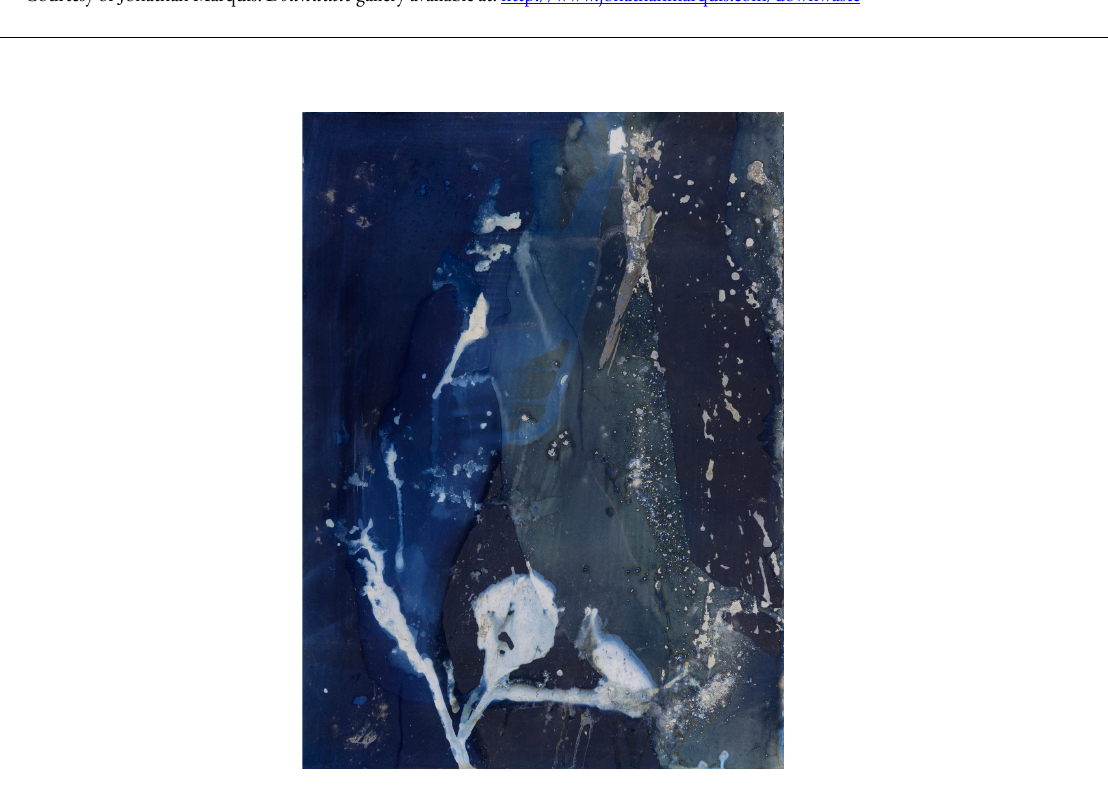
Figure 4: Downwaste (Grinnell II), 2019. Cyanotype on paper 30" x 22". Courtesy of Jonathan Marquis. Downwaste gallery available at: